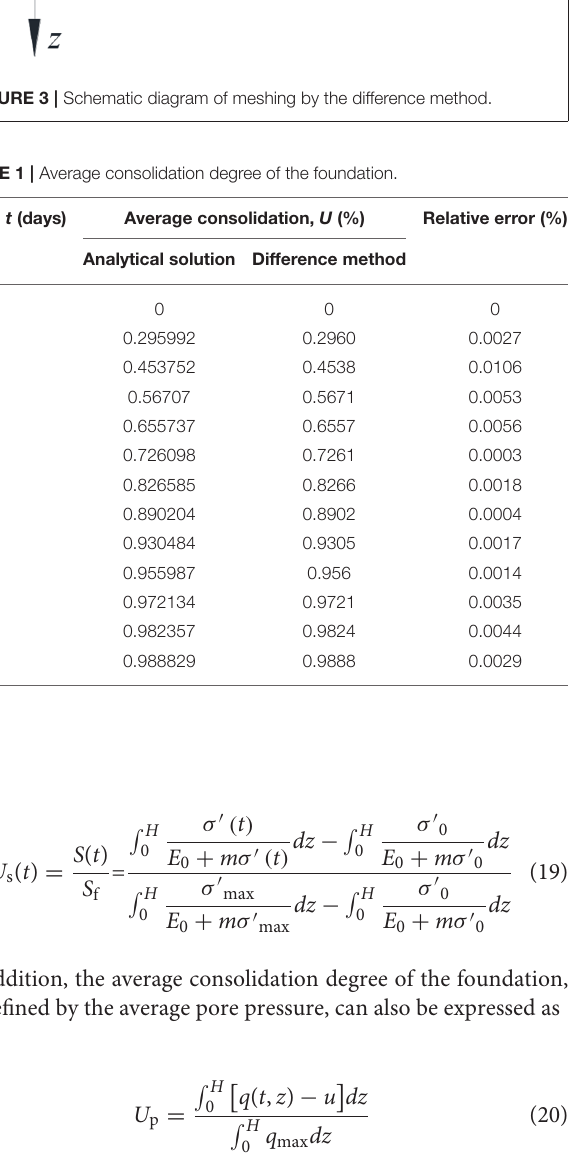
FIGURE 4 | External load curve.